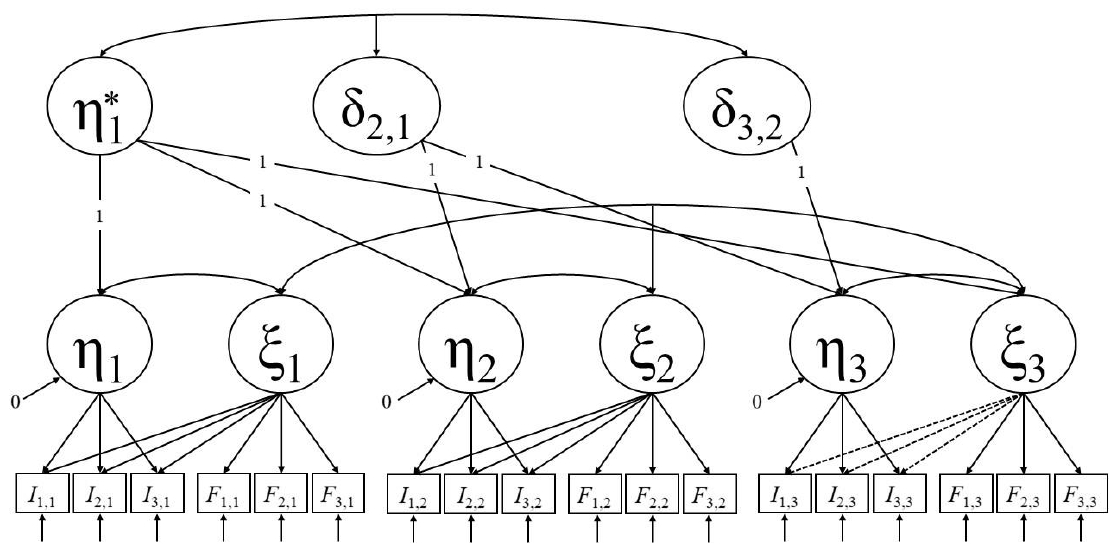
Figure 3. Example of the full interference model with three test sessions. ξ i (with i = 1, 2, 3) depicts situational test anxiety at measurement occasion i . We included a latent variable η *1 for a more comprehensible visualization of the model. η 1 regresses on η *1 with a regression weight of 1 and a residual-variance of 0. Hence, η *1 = η 1 . Note that an inclusion of η *1 is not necessary for model estimation as η 1 can be used for the respective equations instead. By identifying the model by setting the variances of latent variables to 1, the latent differences variables δ k,k−1 (with k = 2, 3) are on a standardized scale and their means can be interpreted as retest effect sizes in terms of Cohen’s d [80]. Interference effects in the third test session are depicted by dashed lines to illustrate the first step of the interference reduction approach. A model in which these coefficients are restricted to zero can be compared with the full interference model via a likelihood ratio test to test the null hypothesis that interferences disappear in the third test session.